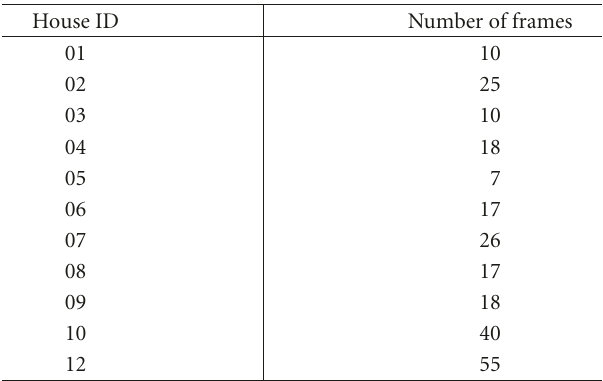
Table 1: Threshold for home-environment adaptation—minimum amount of data needed to estimate Δ j .